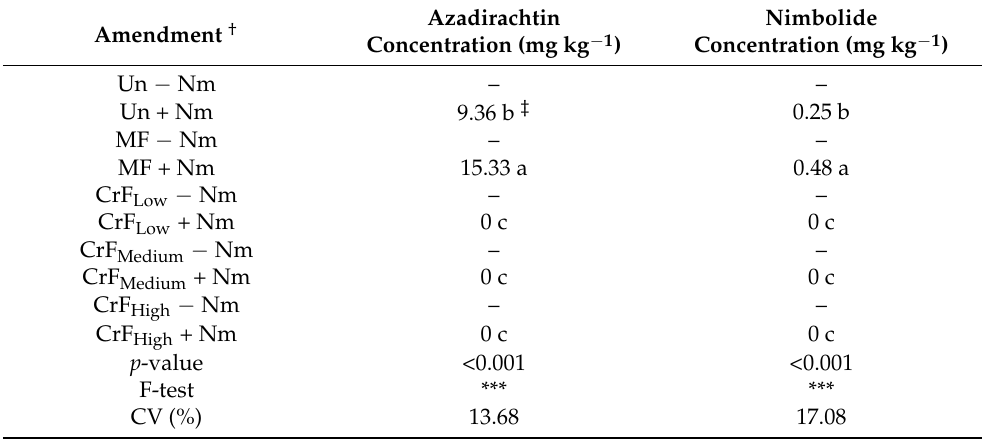
Table 4. Azadirachtin and nimbolide concentrations in soil at the completion of the experiment as affected by the combined uses of different rates of cricket frass and neem seed